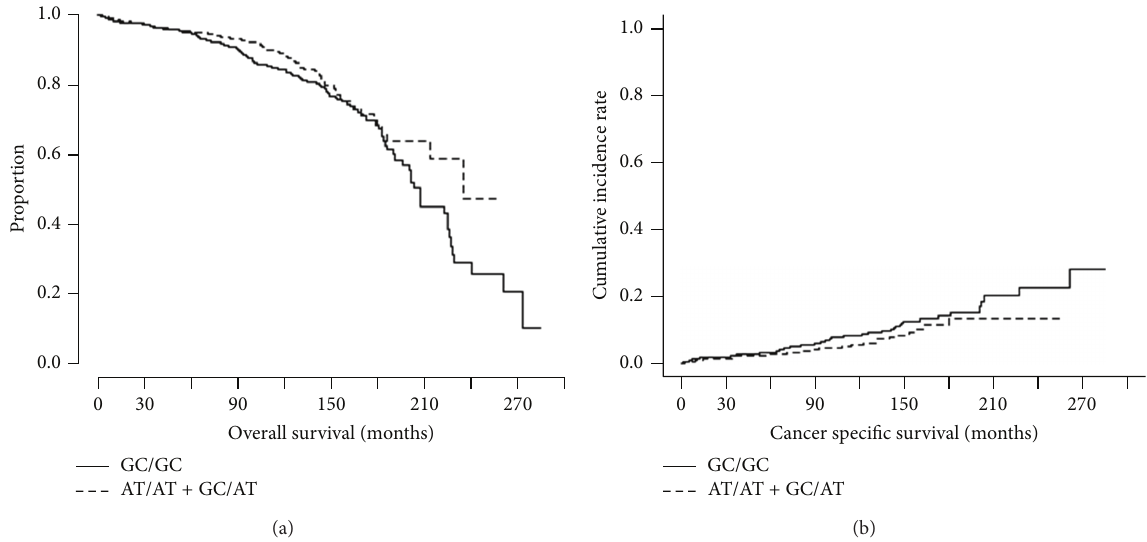
Figure 1: Association between rs1801173 and overall survival (a) and prostate cancer specific survival (b). A role of p73 DNP in prostate cancer progression and aggressiveness was investigated. p73 DNP is marginally associated with overall death (dominant model, hazard ratio (HR) = 0.76, 95%CI = 0.57–1.00, 𝑃 = 0.053 by Cox regression adjusted for age) as well as PCa specific death (HR = 0.69, 95%CI = 0.45–1.06, 𝑃 = 0.09 by the competing risk regression adjusted for age).